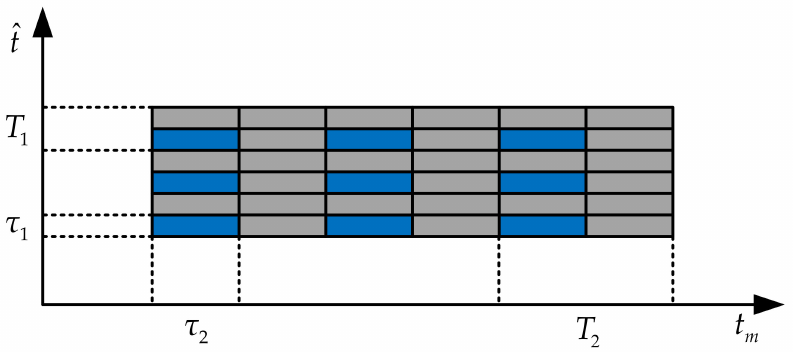
Figure 2. Schematic diagram of interrupted sampling in fast and slow time